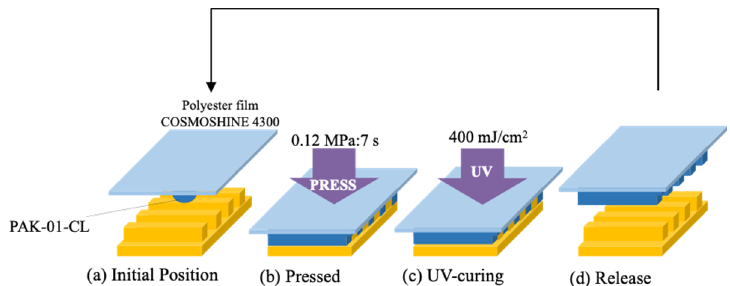
Figure 4. The process of repeated transcription.